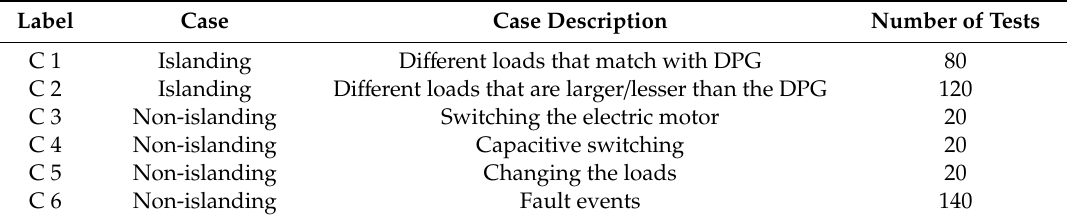
Table 2. Simulated cases using TQWT